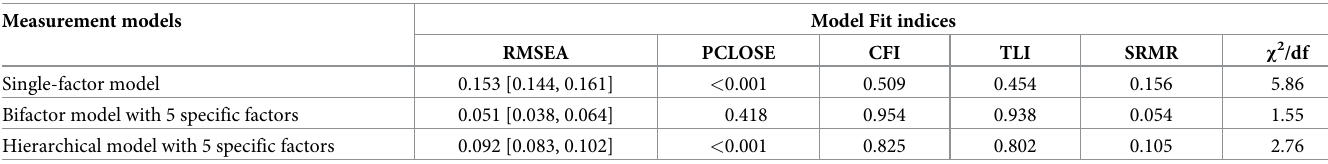
Table 6. Model fit indices of three measurement CFA